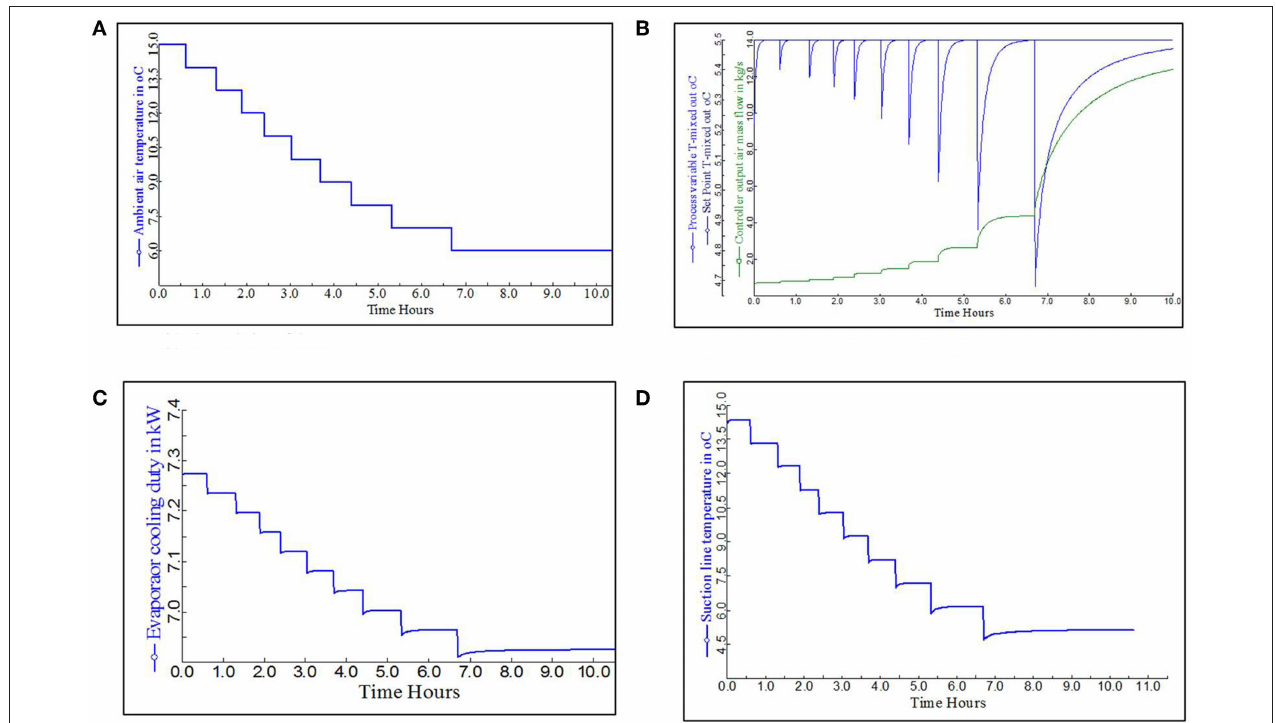
FIGURE 9 | Variation of different operation parameters. (A) The variation of the ambient air temperature over the time lapse. (B) PID controller performance for ambient temperature range 6-15 ◦ C. (C) The variation in evaporator cooling capacity over the time lapse. (D) The variation in suction line temperature over the time lapse.